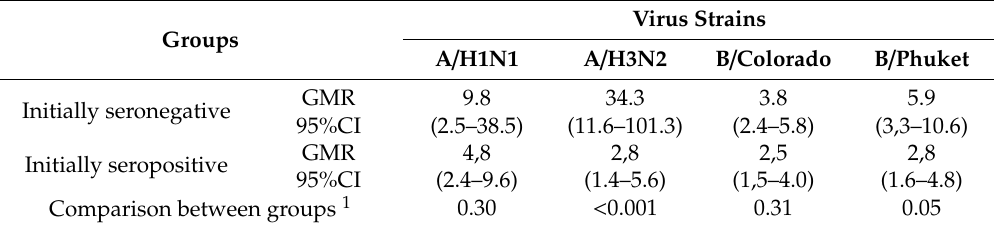
Table 3. Geometric mean rate (GMR) in the group of healthy given the initial level of antibodies in the group of healthy participants.